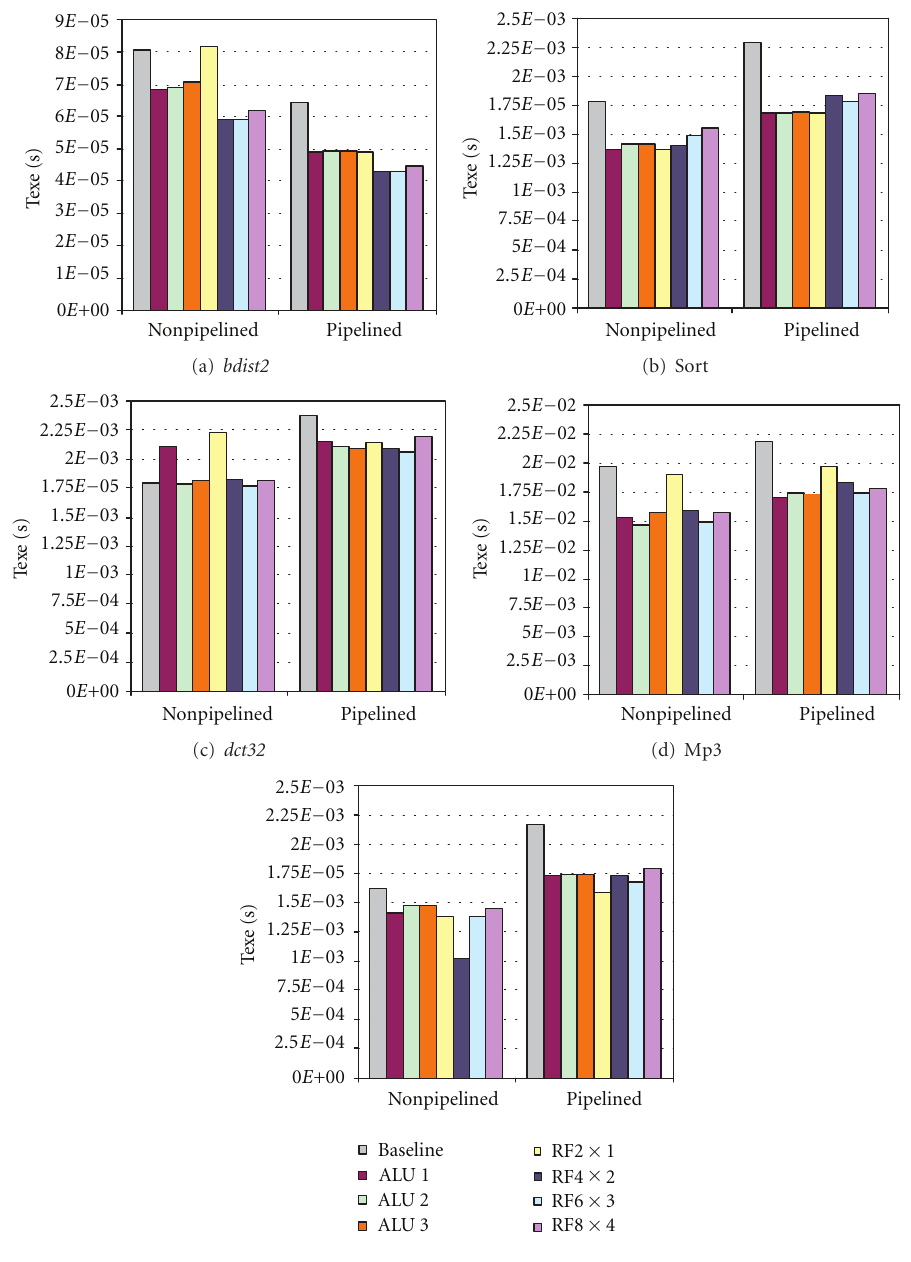
Figure 14: Total execution time on generated data